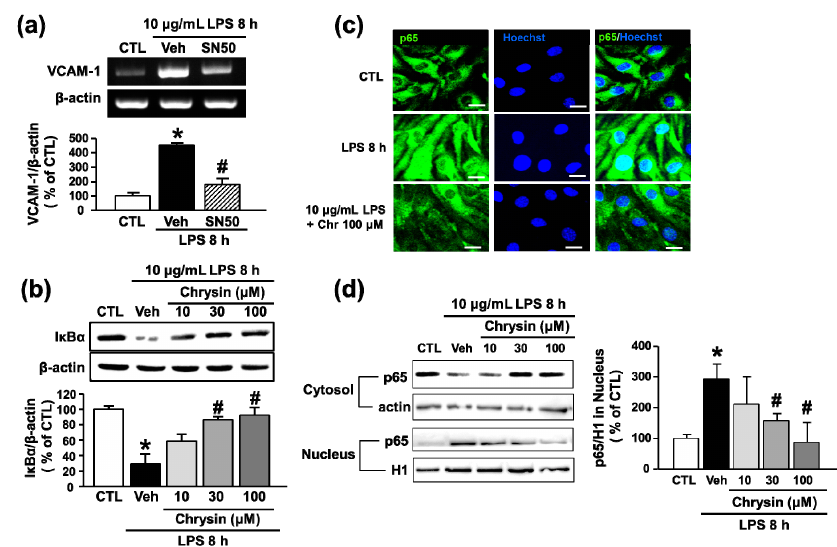
Figure 3. The effect of chrysin on LPS-induced translocation of NF- κ B in bEnd.3 cells. ( a ) Cells were pretreated with SN50 for 30 min and co-stimulated with LPS (10 µ g/mL) for 8 h. The levels of VCAM-1 mRNA were evaluated by RT-PCR and quantified by densitometry; ( b ) cells were pretreated with chrysin (10–100 µ M) for 30 min and then stimulated with LPS (10 µ g/mL) for 8 h. Whole cell and nuclear extracts were prepared and analyzed by Western blot analysis with anti-I κ B α antibody. The levels of protein were normalized with β -actin; ( c ) cells were pretreated with chrysin (10–100 µ M) for 30 min and then co-stimulated with LPS (10 µ g/mL) for 8 h. NF- κ B p65 (green) was detected by immunofluorescence using anti-p65 antibody. Nuclei were visualized by Hoechst staining (blue). Scale bar: 20 µ m; and ( d ) Western blots of p65 subunit of NF- κ B in nucleus and cytosolic fraction of bEnd.3 cells treated with LPS (10 µ g/mL) and chrysin for 8 h. Actin was used as internal standard of cytosol fraction and histone 1 (H1) of the nuclear fraction. * p < 0.05 vs. control without LPS and # p < 0.05 vs. vehicle without SN50, n = 3.